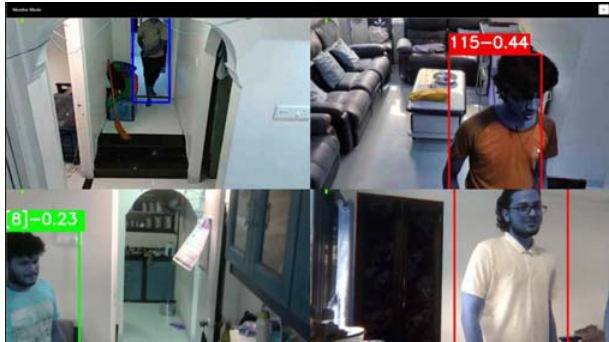
Fig18: Red Box and green box detection of negative as